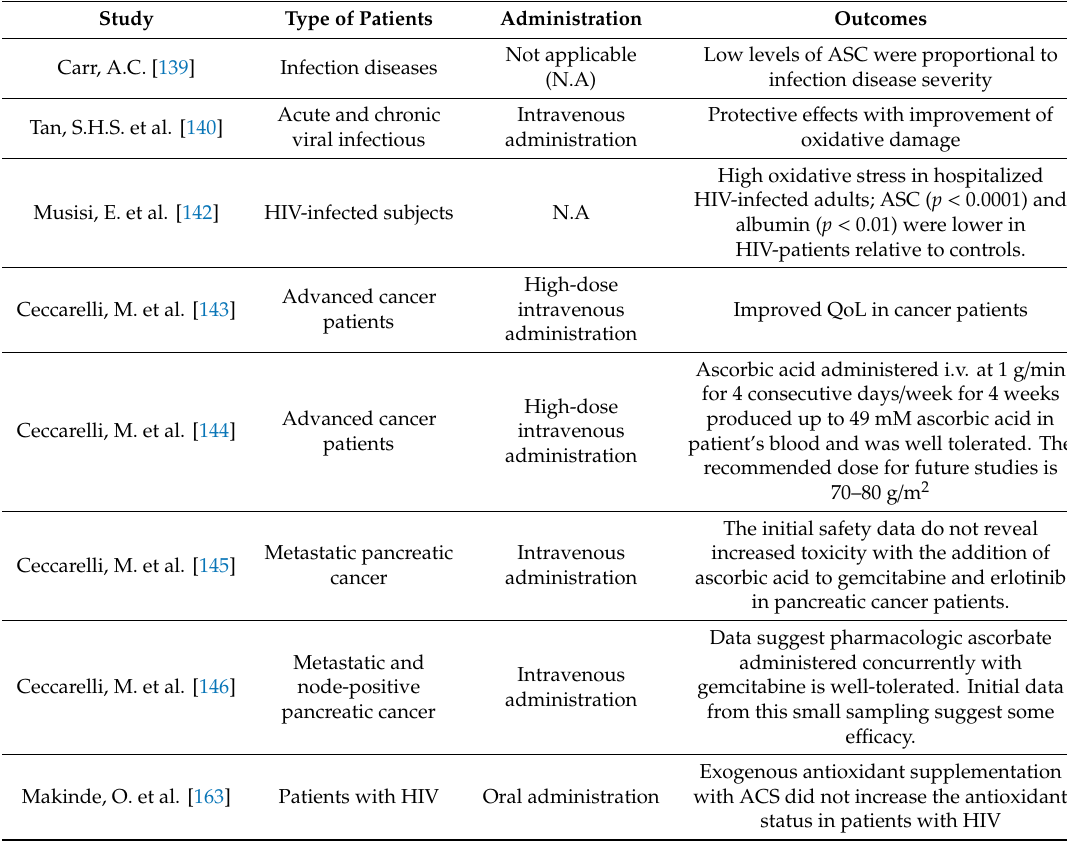
Table 5. Clinical trials and meta-analysis based on the immune-stimulating e ff ects of ASC.